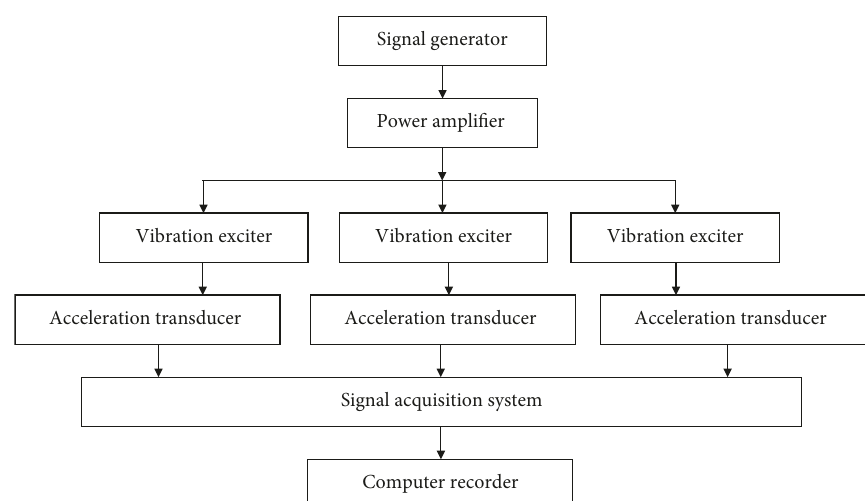
Figure 13: Process of dynamic property test with forced vibration method.